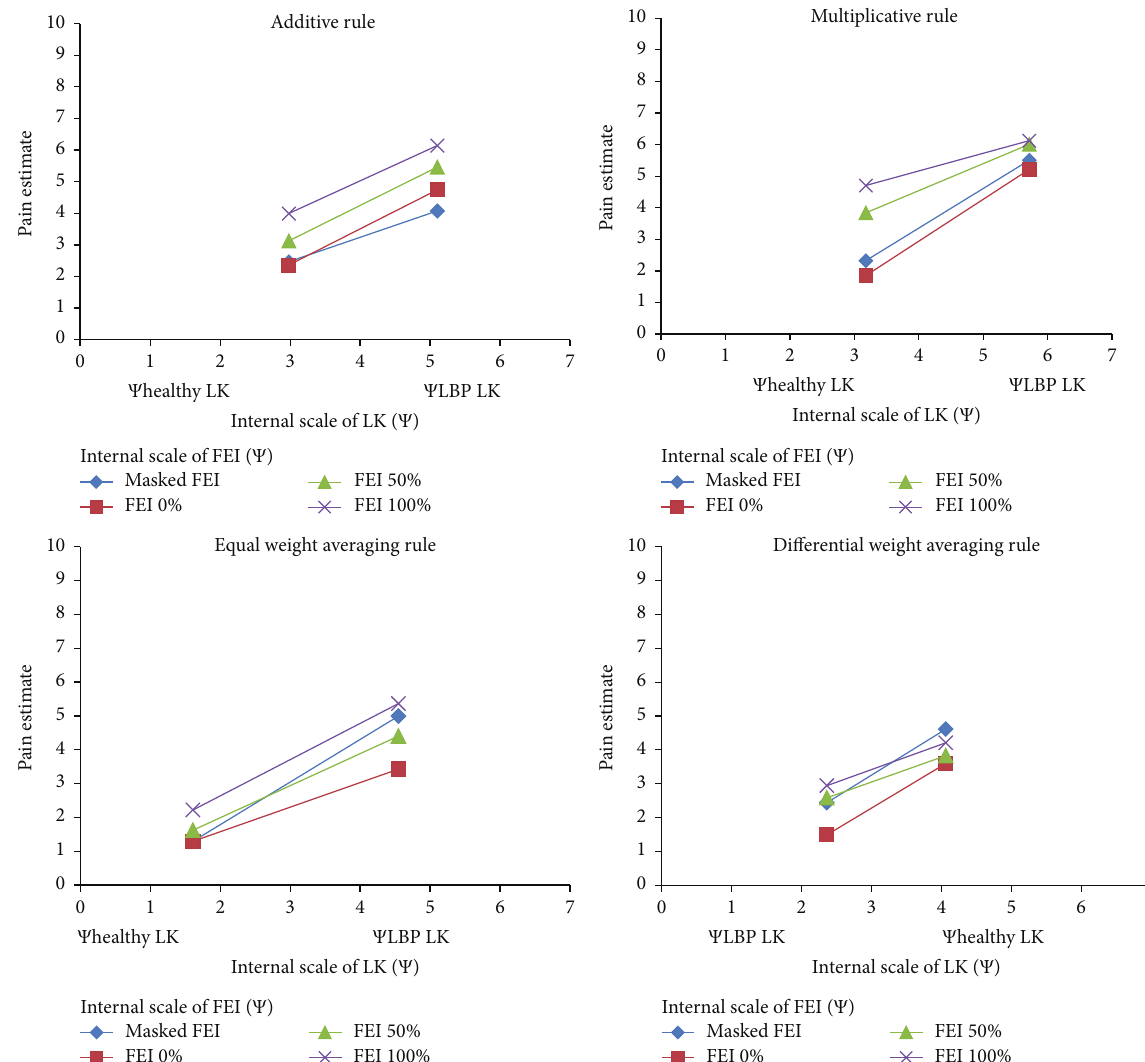
Figure 5: Illustrations of individual differences in participants who integrated both lumbopelvic kinematics (LK) and facial expression intensity (FEI). The functional data of participants’ responses is expressed as a function of their subjective scaling Ψ healthy LK and Ψ LBP LK, corresponding to each physical stimulus value to Φ healthy LK and Φ LBP